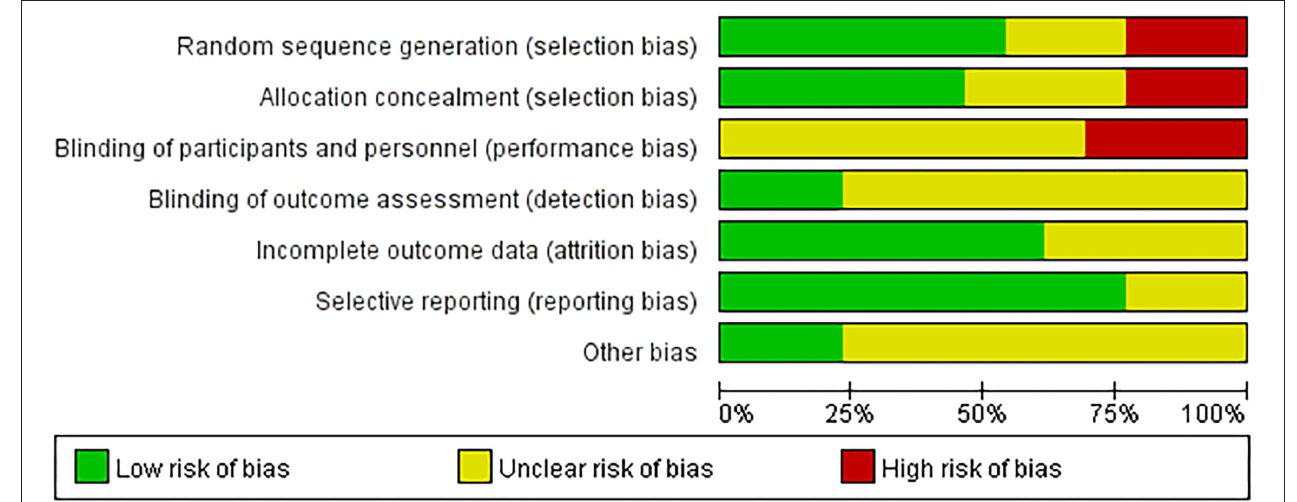
FIGURE 2 | Risk of bias graph: judgment on each risk of bias item presented as a percentage across all included